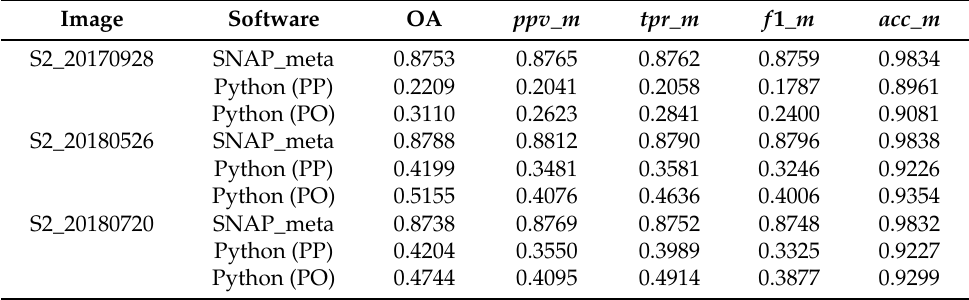
Figure 4. The impact of the image registration date and the number of classified images on the classification accuracy- selected metrics: OA and f 1 m . Classification in SNAP with RF algorithm with sampling method (50,000 training/50,000 val- idation samples). Accuracy assessment on validation set—red points, on test set: pixel approach—yellow points, object approach—purple points. Table 10. The accuracy metrics of validation calculated from SNAP_meta sampling method (50,000 training/50,000 validation samples) and accuracy metrics calculated from the entire test set in the pixel and in the object-oriented approach Python (PP) and (PO).